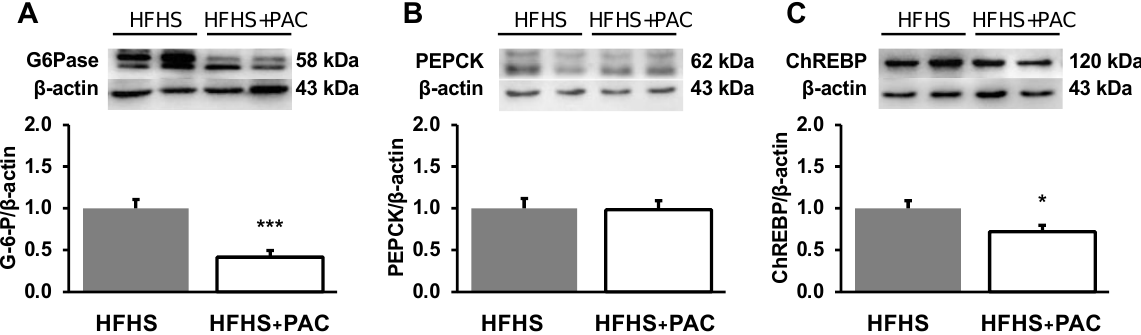
Figure 8. PACs modulate glucose metabolism in liver HFHS-fed mice. Protein mass of ( A ) G6Pase, ( B ) PEPCK as well as the transcriptional factor ( C ) ChREBP was assessed by Western blot as de- scribed in Materials and Methods. Data are expressed as the mean ± SEM for n = 4 – 7 mice/group with a representative gel per experiment. * p < 0.05, *** p < 0.001 vs. HFHS mice. Each set of experi- ments, including the proteins of interest and their β -actin (as a reference protein and a loading housekeeping control) was run on the same gel. G6Pase: Glucose 6-phosphatase; PEPCK: Phosphoe- nolpyruvate carboxykinase; ChREBP: Carbohydrate response element binding protein.